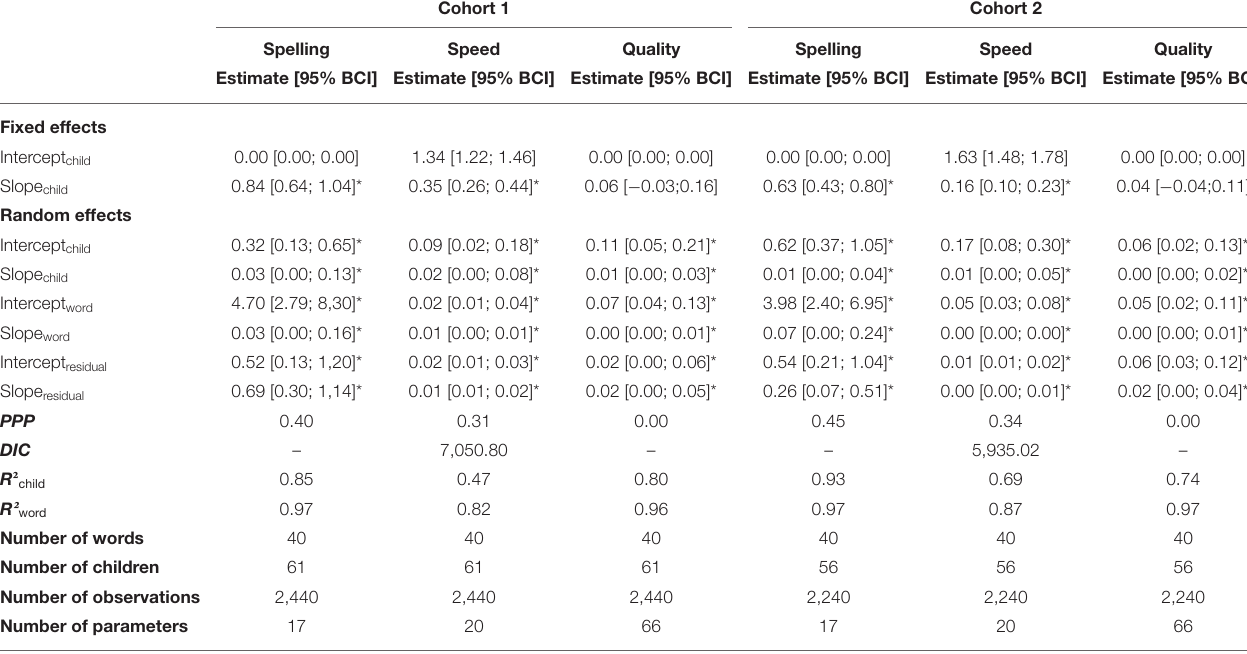
TABLE 4 | Estimates of the unconditional linear growth curve models for spelling accuracy, handwriting speed, and handwriting quality.